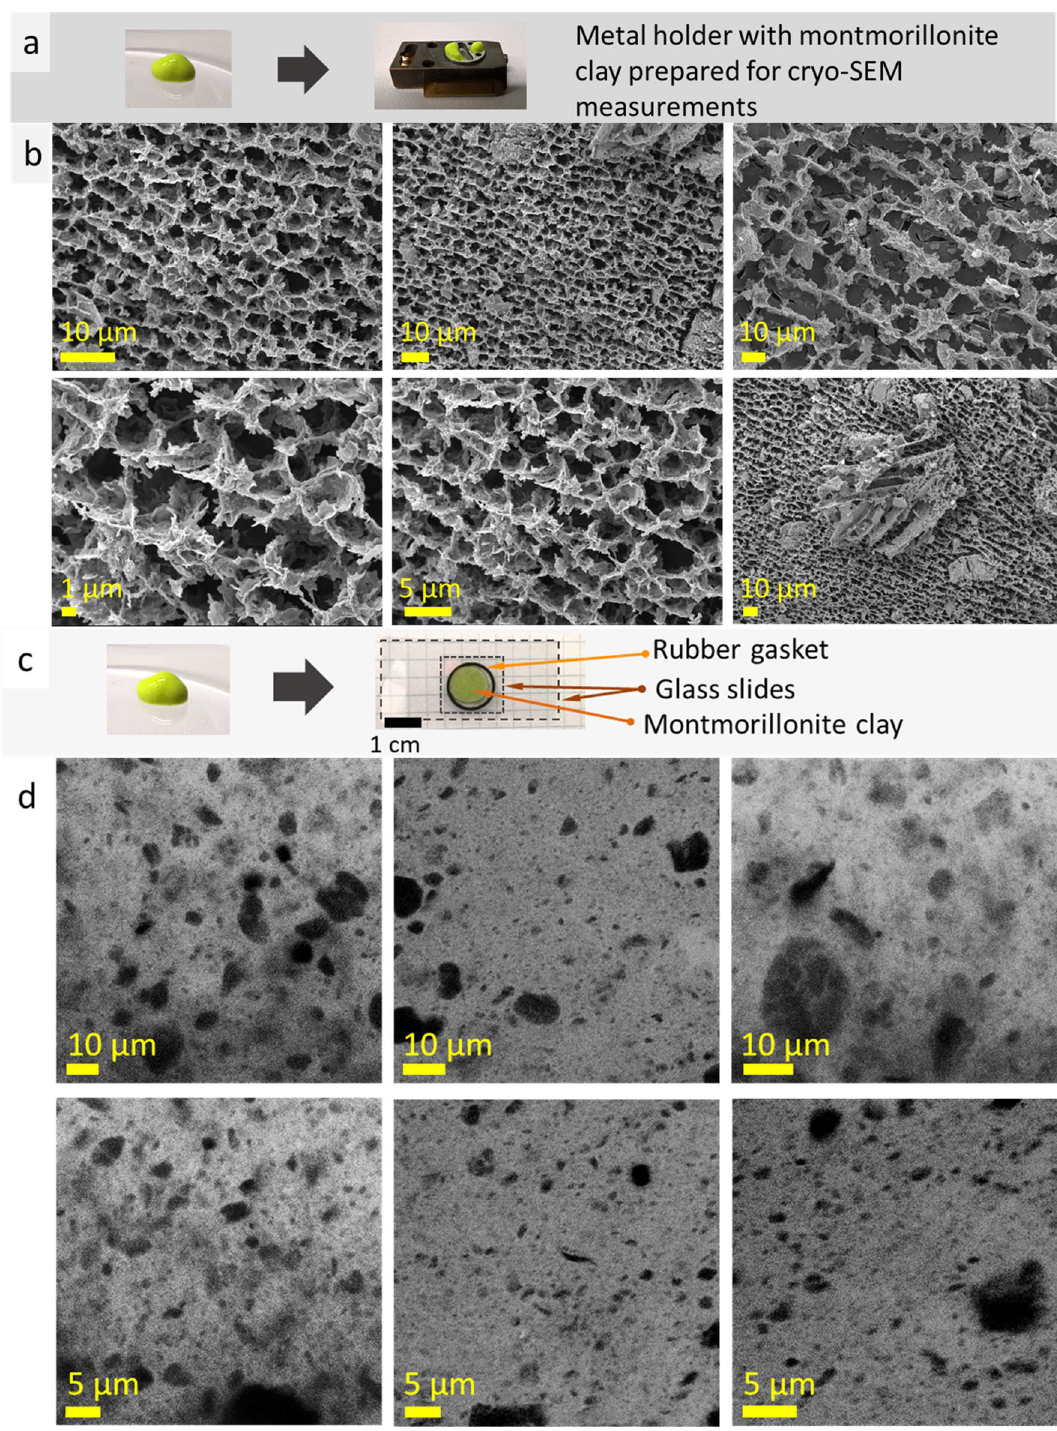
Figure 6. Photos of a montmorillonite clay with fluorescein, specimen shuttle with the sample for cryo-SEM ( a ), cryo-SEM images of montmorillonite clay with fluorescein ( b ). Photos of a montmorillonite clay with fluorescein, a drop between the glass slides with rubber gasket for confocal LSM imaging ( c ); confocal LSM images obtained at excitation 405 nm, laser power 0.002 mW (light—montmorillonite, dark—water) ( d